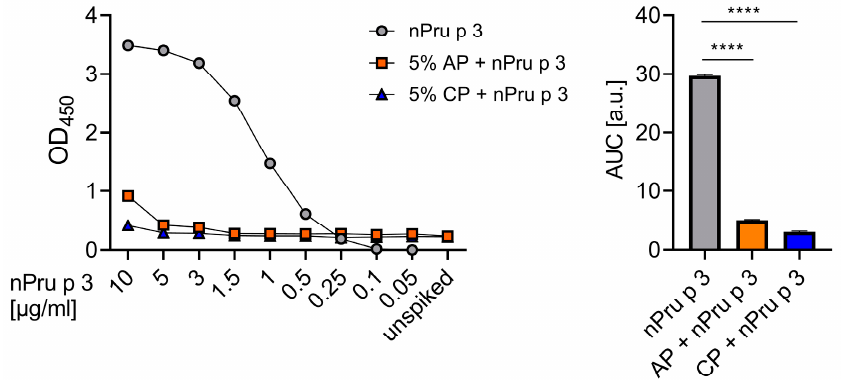
Figure 2. Detectability of nsLTPs in 5% apple-derived pectin (AP) and 5% citrus-derived pectin (CP) was evaluated by Pru p 3 (peach nsLTP)-sIgE ELISA. The nsLTP detectability was compared using the area under the curve (AUC). ****= p < 0.0001. Similar results were obtained in immunoblots with nsLTP specific IgG using a rabbit antiserum (Figure 3).